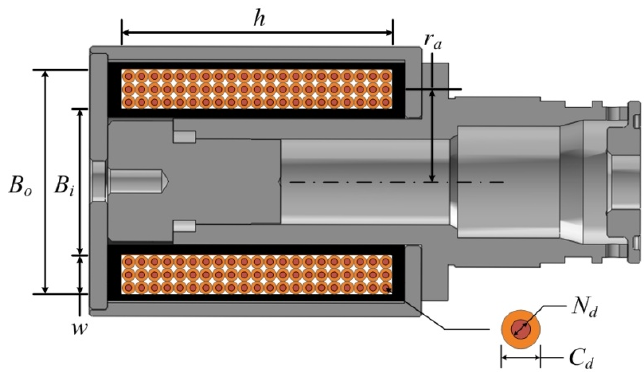
Figure 3. Schematic diagram of coil bobbin.